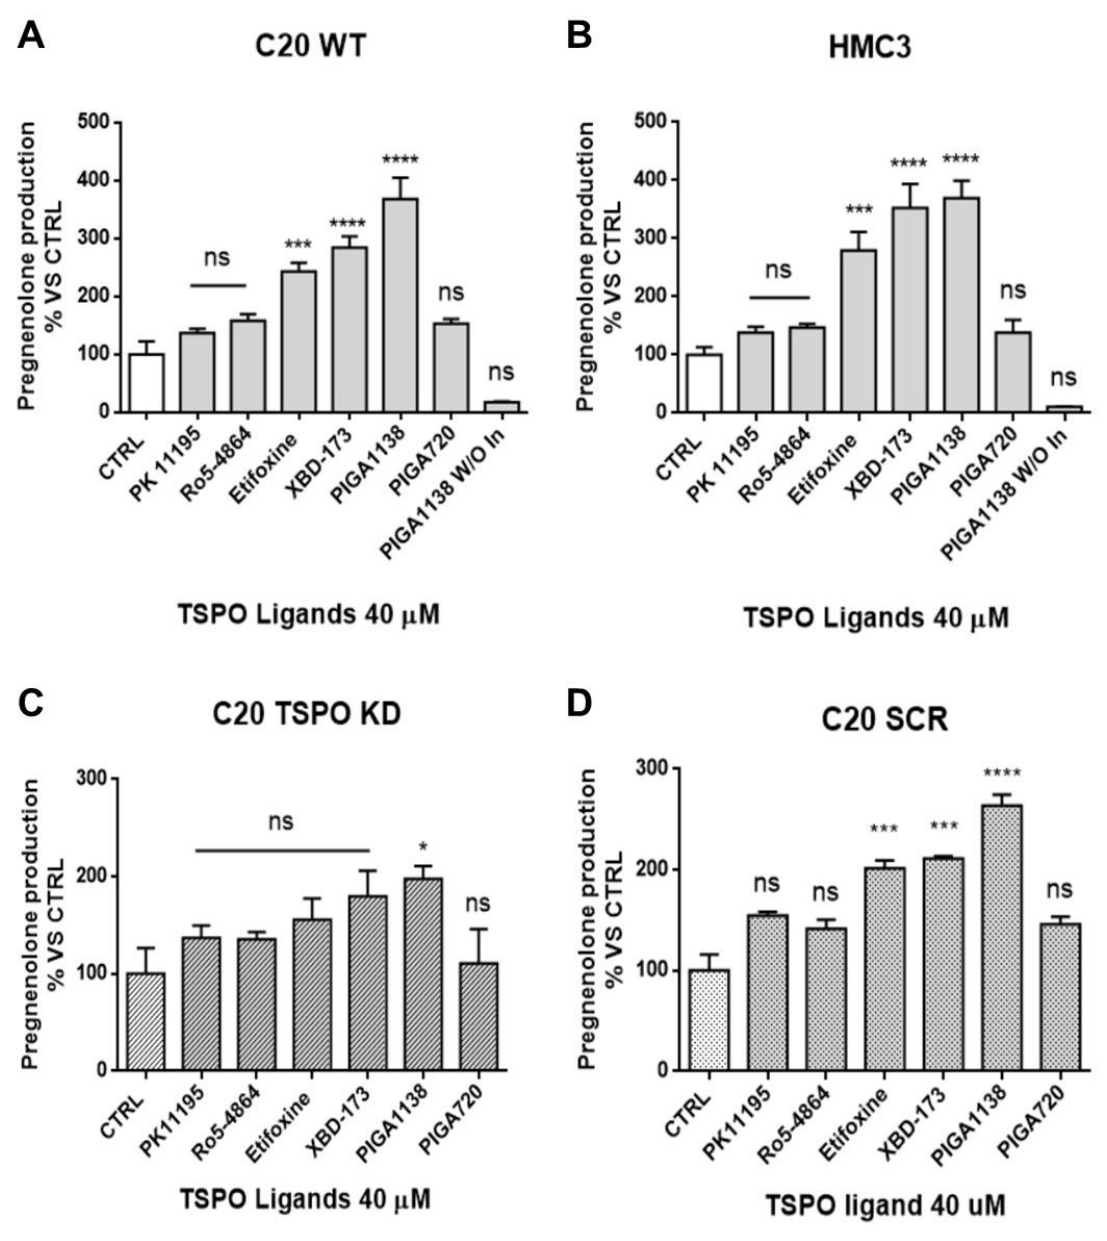
Figure 6. Pharmacological stimulation of neurosteroidogenesis by TSPO synthetic ligands in human microglial cells. ( A , B ) Cells were treated with TSPO ligands for two hours. After incubation, the saline medium was collected and used for the pregnenolone ELISA. The figure shows how TSPO ligands significantly promoted neurosteroidogenesis, particularly after the treatment with ligands characterized by high residence time (RT) at the TSPO binding site: etifoxine, XBD-173, and PIGA1138. The absence of pregnenolone metabolism inhibitors abolished pregnenolone accumulation in microglial cells treated with the most potent steroidogenic compound PIGA1138. ( C ) The TSPO knock-down reduced the TSPO ligands’ capacity to increase neurosteroidogenesis de novo, expect for PIGA1138. ( D ) TSPO ligands promoted de novo steroid production in C20 SCR control cells. Data are represented as means ± SEMs of independent experiments. The significance of the differences was determined by one-way ANOVA, which was followed by Bonferroni’s post-test: * p < 0.05, *** p < 0.001, **** p < 0.0001 vs. control.